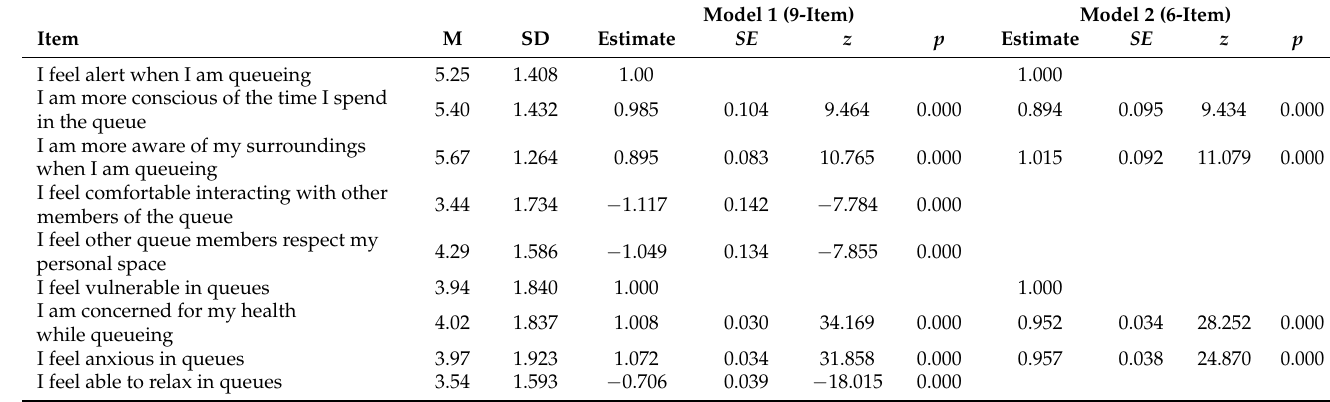
Table 2. Descriptive statistics and estimates from the queue awareness confirmatory factor